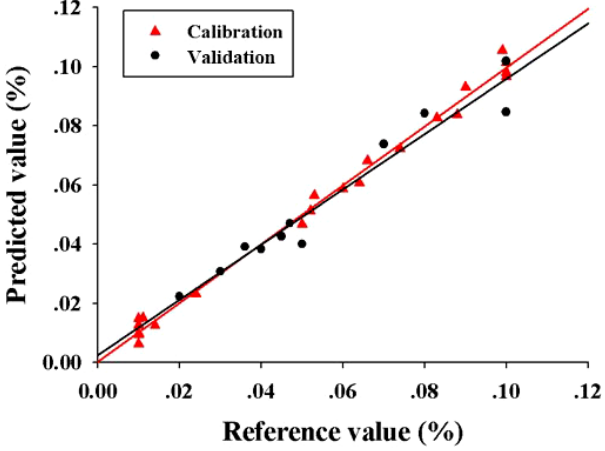
Fig. 2. CPM NIR predictions versus the reference result.